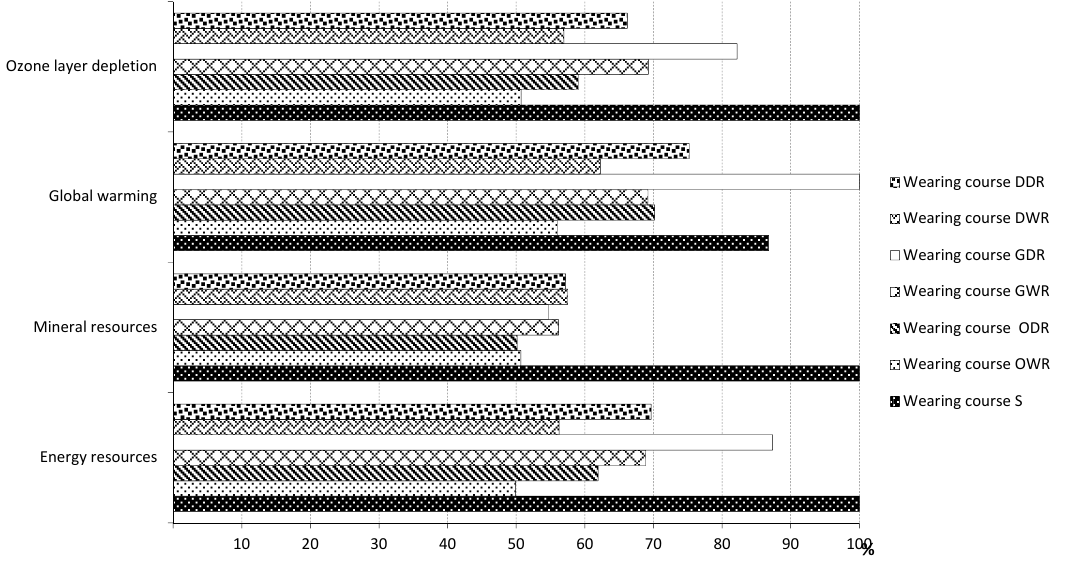
Coatings 2019 , 9 , x FOR PEER REVIEW Figure 5. Contribution of the pavement layers to selected impact categories, scenario S.